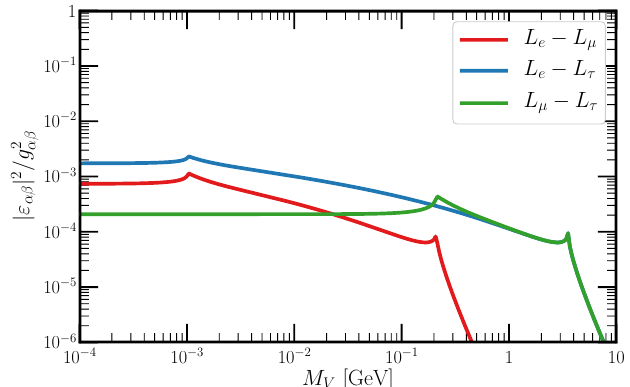
2 (relative to the gauge coupling squared) given by eq. (5.1) as a Figure 8 . Kinetic mixing " j j function of vector boson mass M V for the three di(cid:11)erent leptophilic gauge bosons: L e L e L (cid:28) (blue), and L (cid:22) L (cid:28) (green). Here, we assume the only contribution to the kinetic mixing (cid:0) (cid:0) is from the massive standard model fermions generating a loop process connecting the standard model photon and V